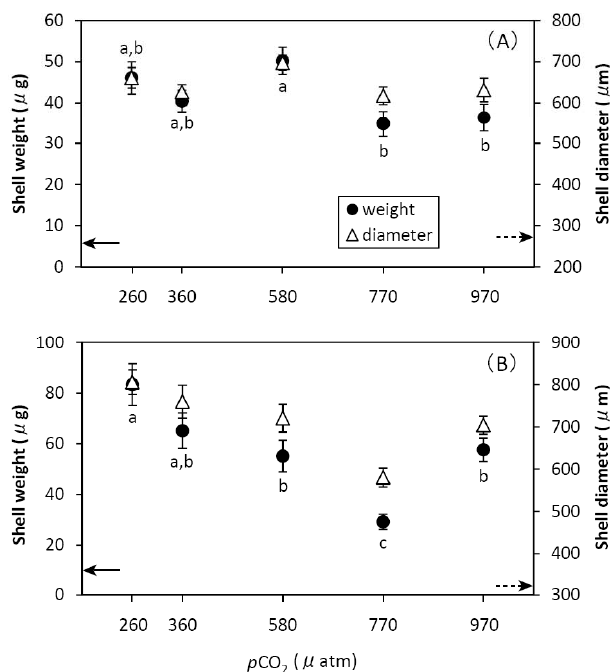
Fig. 5. Mean shell diameter and weight of Amphisorus hemprichii after culture for about 12 weeks at five p CO 2 levels. Values are means ± SE of the 20 clone individuals sampled in each treatment. Different letters above plotted treatment values indicate a significant difference ( α = 0.05) in shell weight according to Tukey’s HSD post hoc test. Dashed and solid arrows show mean shell diameter and weight of clone individuals, respectively, at the start of experiment. (A) Population α , (B) population β